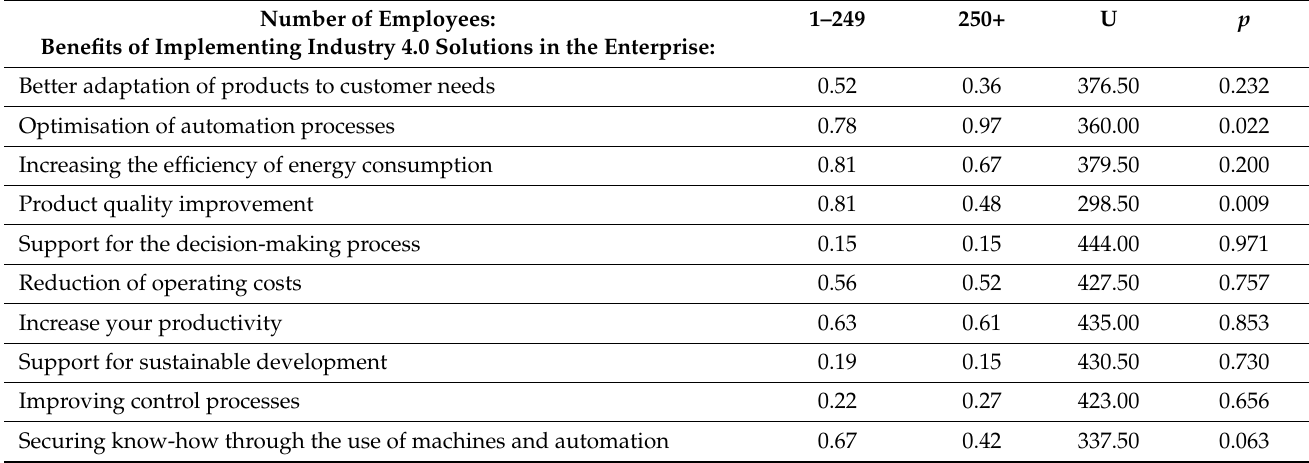
Table 9. Assessment of benefits to implementing Industry 4.0 solutions in the enterprise in companies employing up to 249 participants and in companies employing at least 250 participants.